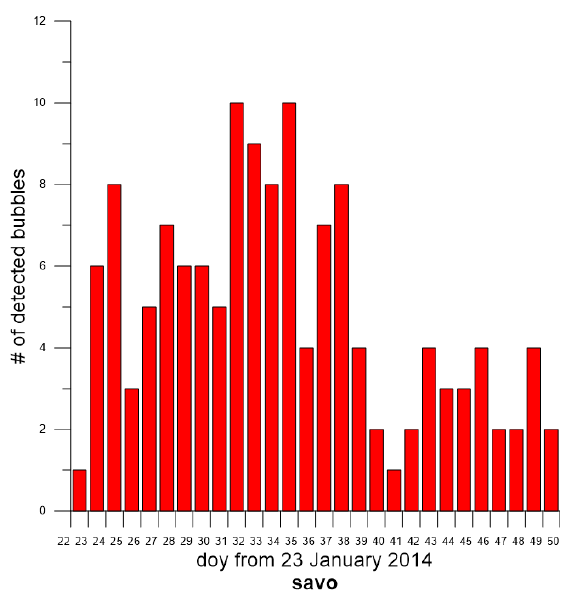
Figure 11. Number of plasma depletions indicating equatorial plasma bubbles (EPBs) detected over Savo station (Lat: 12.93 ◦ S, Lon: 38.43 ◦ W) for Campaign 2013–14. The number of plasma depletions have been obtained using the method described in